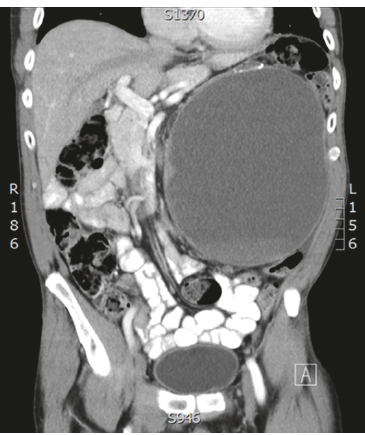
Figure 1: CT abdomen coronal view showing a large left cystic renal mass displacing great vessels laterally.